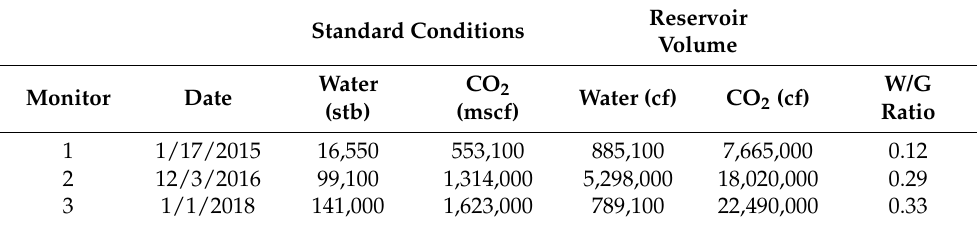
Table 2. Cumulative volumes of water and gas injected from the time of the baseline survey at surface and reservoir conditions, and in equivalent bulk reservoir volumes using a porosity of 0.15 and S wirr =